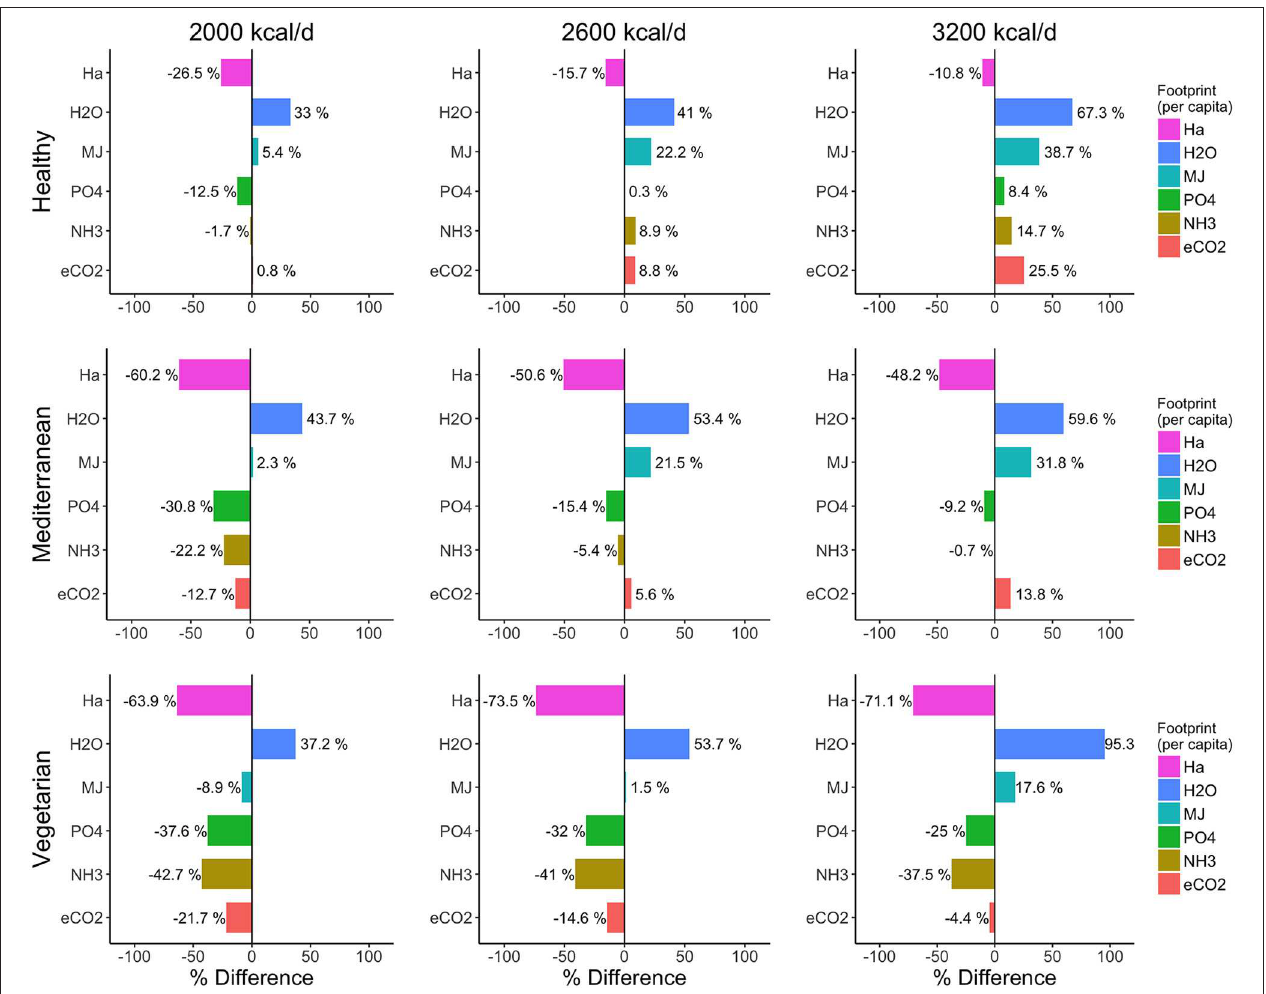
FIGURE 2 | Relative percent difference in land area (purple), energy (blue), phosphate (green), water (olive) inputs as well as CO 2 greenhouse gas equivalent emissions (red) required for the production, processing and transport to retail for the nine dietary scenarios as compared with the impacts for the current diet ( sensu Rehm et al., 2016 ) based on LCIA estimates of food groups by Meier and Christen